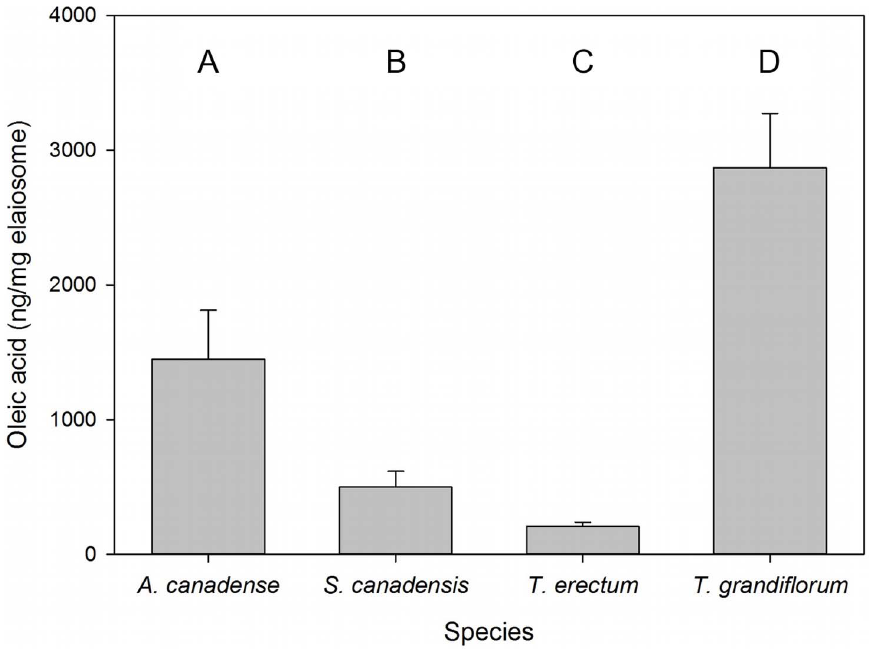
Figure 3. Oleic acid content of the focal myrmecochorous species. Mean ( 6 SE) concentration of free oleic acid in elaiosomes. Different letters indicate statistically significant differences (Tukey-adjusted p # 0.05).